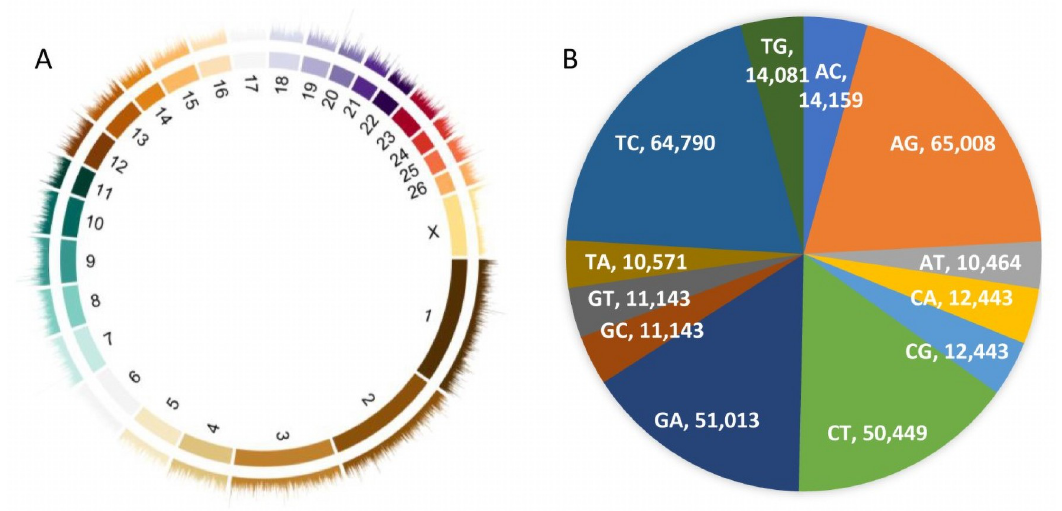
Fig 2. Distribution density across 27 chromosomes (A) and substitution types (B) of clean single nucleotide polymorphisms (SNPs) in this